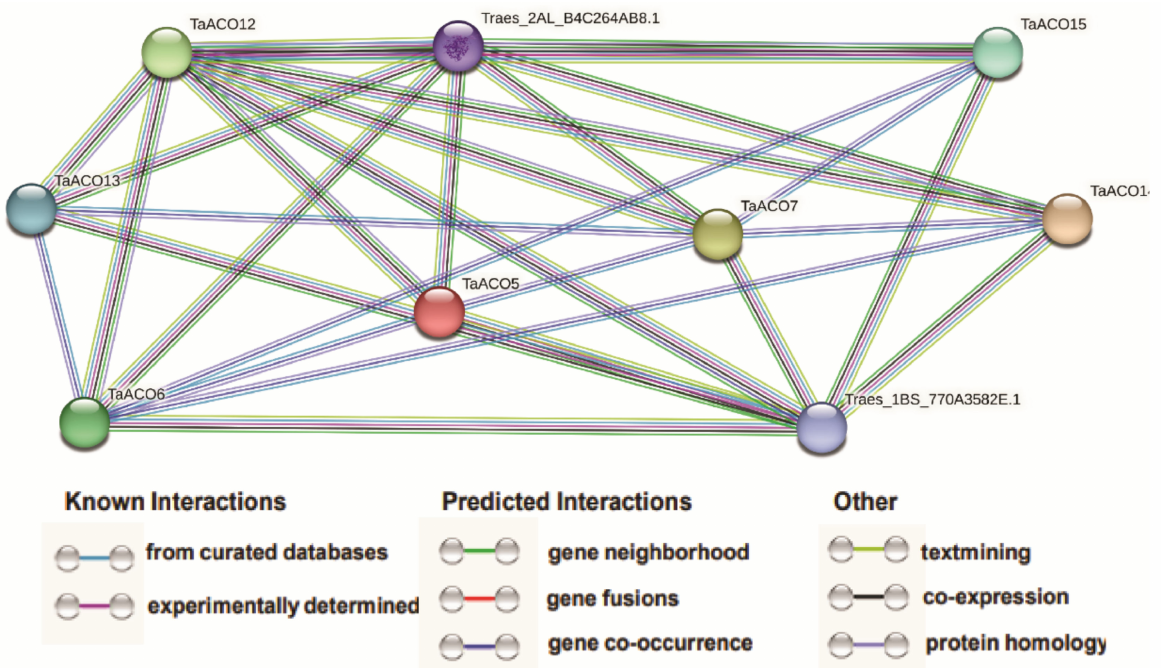
Figure 10. Protein–protein interaction (PPI) analysis of TaACOs proteins. PPI network generated via STRINGV9.1. Each knob denotes a protein, each edge represents an